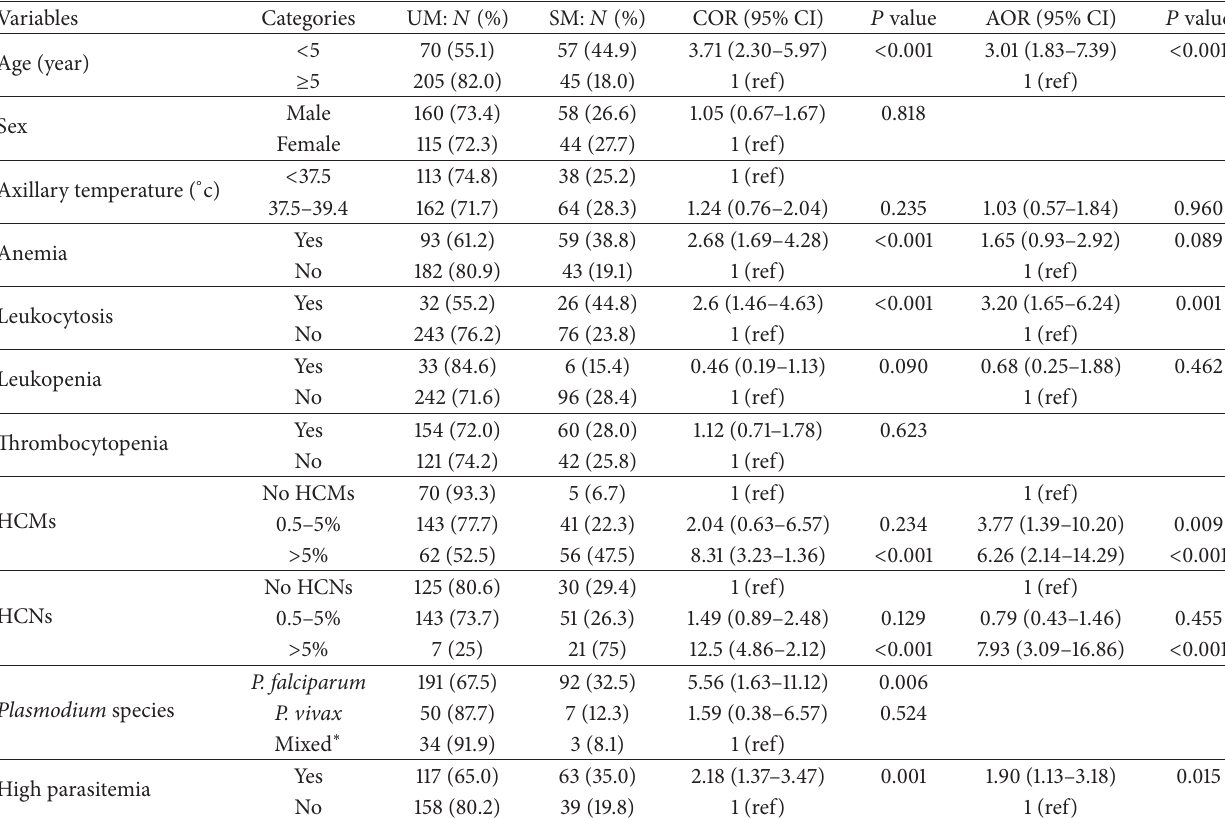
Table 3: Factors associated with of severe malaria among the study participants, Pawe General Hospital,